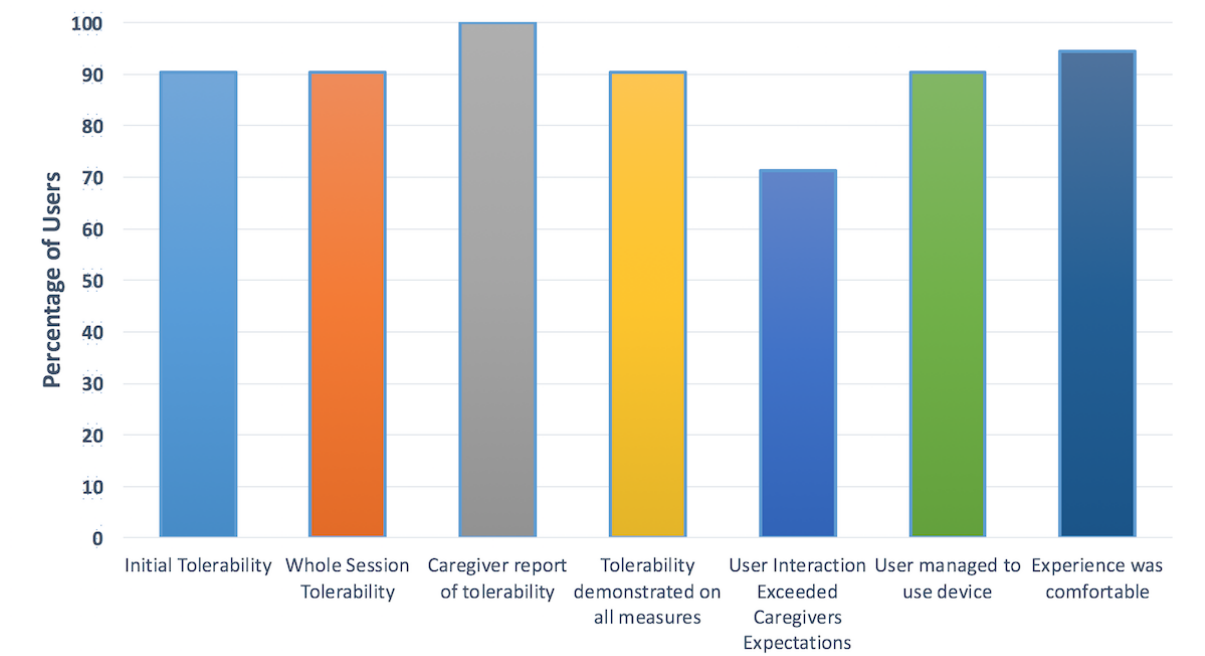
Figure 3. Summary of Brain Power Autism System tolerability and